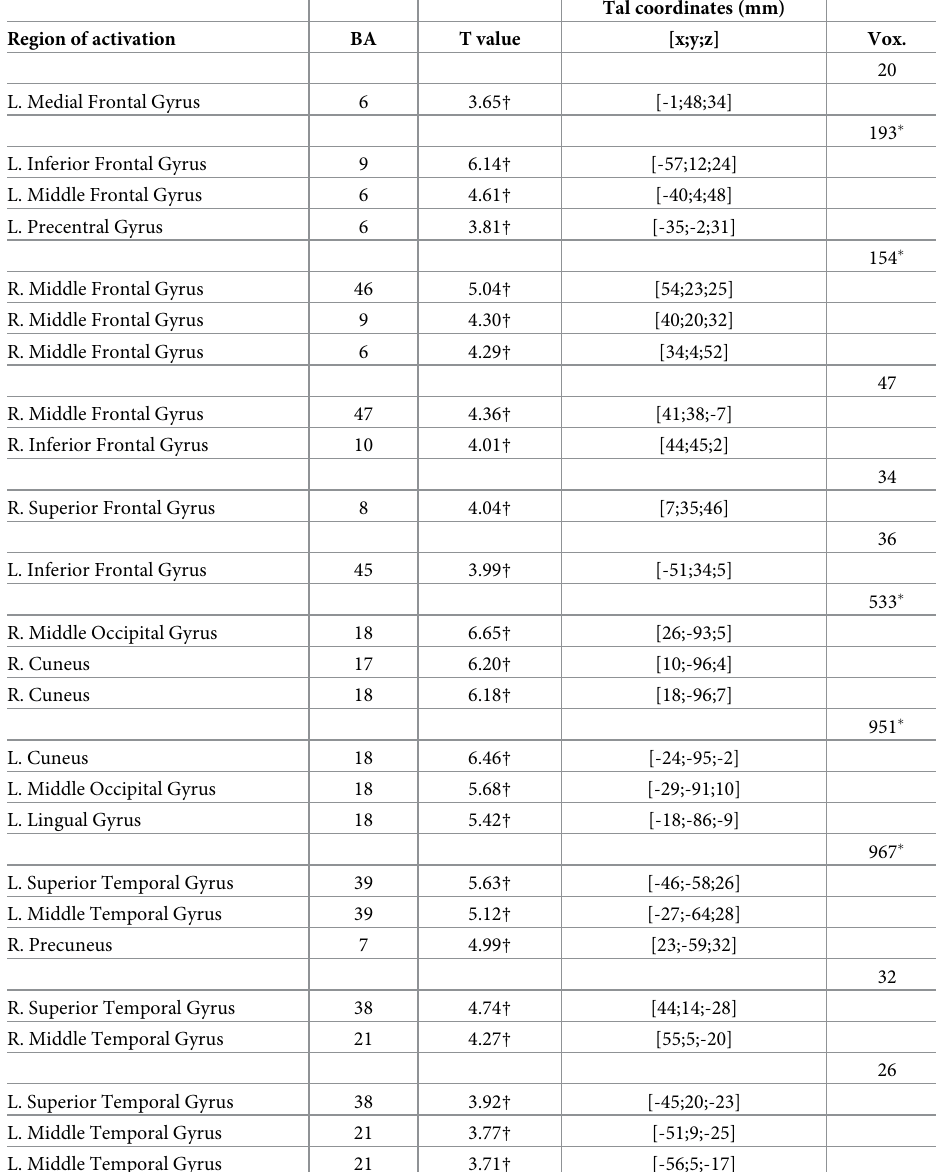
Table 3. Activations associated with explosiveness in whole-brain